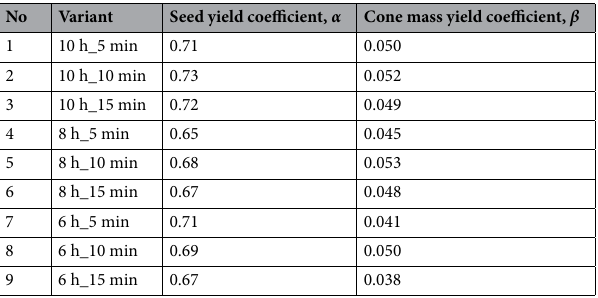
Average for the whole process Quality